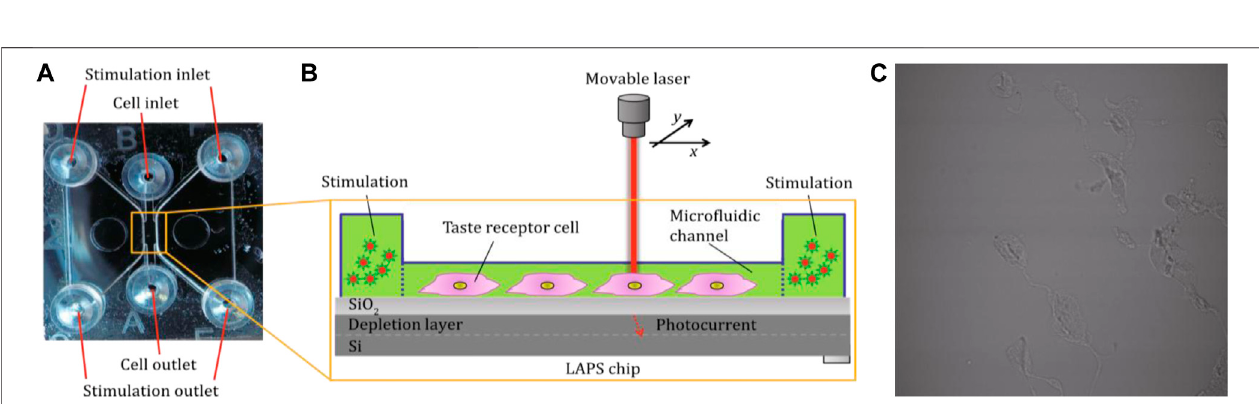
FIGURE 7 | (A) Cell culture microanalysis system based on the LAPS. The cell culture chip includes two stimulation microcavities and one cell culture microcavity (B) The structure of the cell culture microcavity, which is combined with the LAPS to detect the change of membrane potential of taste receptor cells; (C) Cells in the micro fl uidic channel (Du et al.,